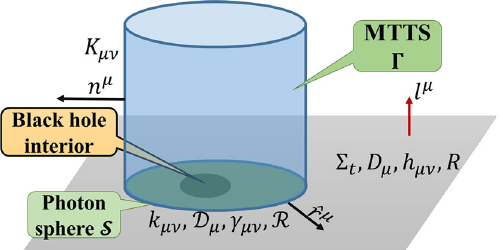
Fig. 1 Notations in the MTTS and photon sphere. For convenience, we immerse all the vectors/tensors into the 3+1 dimensional spacetime and so their indexes become spacetime indexes. For example, h μν = e a μ e b ν h ab , where e a μ is the pull-black map from spacetime to the equal- t